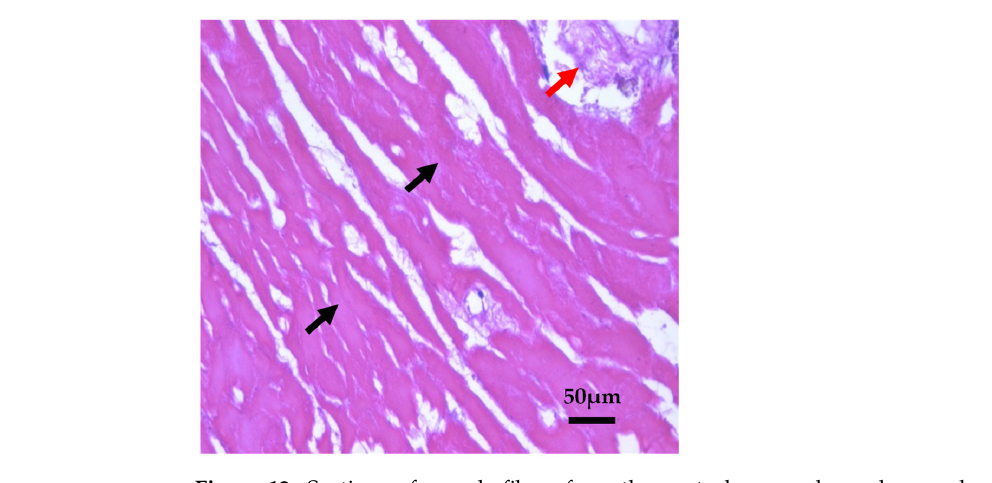
Figure 12. Sections of muscle fibers from the control group showed normal muscle fibers ( black arrow ) and entangling fibrous tissue ( red arrow ) (HE, ×400).